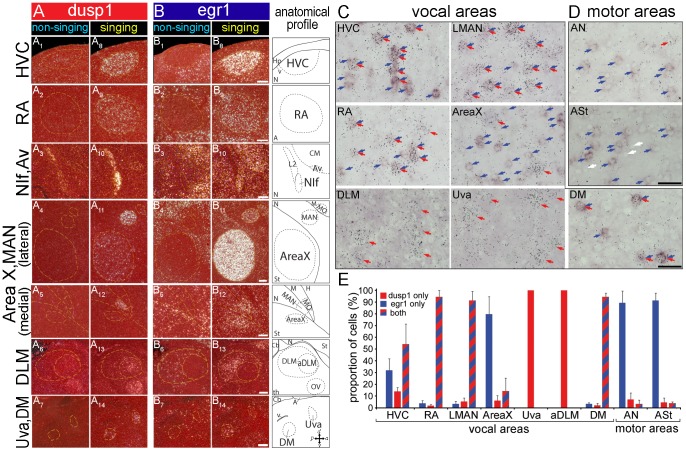
Magnified images of co-expressed dusp1 and egr1 mRNA in vocal areas and adjacent non-vocal areas.(A) dusp1 mRNA expression in song nuclei in a non-singing (A1–7), and singing (A8–14) male that sang for 30 min. (B) egr1 mRNA expression in adjacent sections. Yellow dashed lines, Nissl-stained boundary of areas labeled in anatomical profiles in the right most column. Sections are sagittal; anterior is right, dorsal is up. Scale bars  = 200 µm. (C) Double-labeled images of vocal areas. Egr1 mRNA is labeled with DIG probe as a purple/brown precipitate and dusp1 mRNA is labeled with a S35-probe detected by silver grains. Colored arrows refer to single dusp1 (red), single egr1 (blue), and double labeled (red/blue) cells. (D) Double-labeled images of movement-activated areas adjacent to LMAN (AN) and LAreaX (ASt). White arrows refer to examples of chromogenic background signals with a shadow effect (lighter inside the nucleus), which we used to locate individual cells. Orientation: Dorsal is up and anterior to the right. Scale bars  = 20 µm. (E) Proportion of single and double labeled cells in each area. The relative distribution of double-labeled cells among vocal areas and motor areas are significantly different (p<0.05 and <0.001; AreaX vs ASt and LMAN vs AN, respectively; n  = 3 animals; ANOVA). The distribution of labeled categories in RA and LMAN are significantly different from Area X (p<0.05, ANOVA), where in the latter only large cells are dusp1-labeled and small cells are either egr1-labeled or double-labeled.